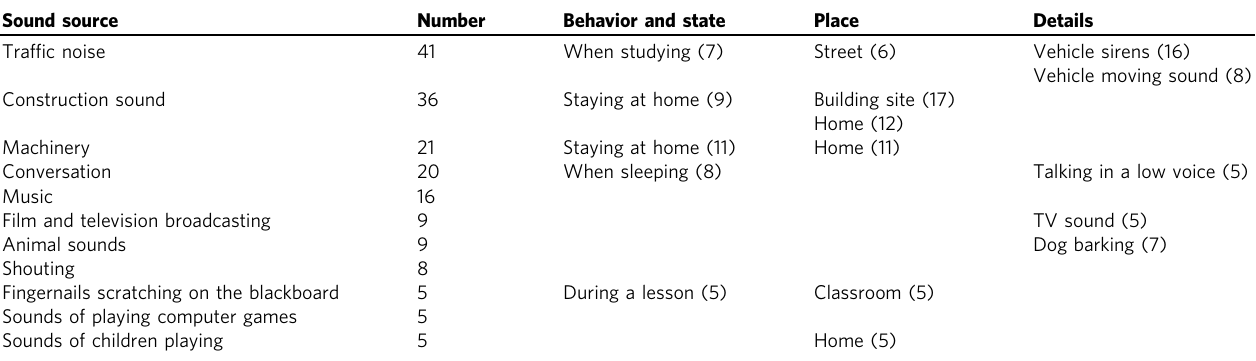
Table 2 Sound sources easily identi fi ed as